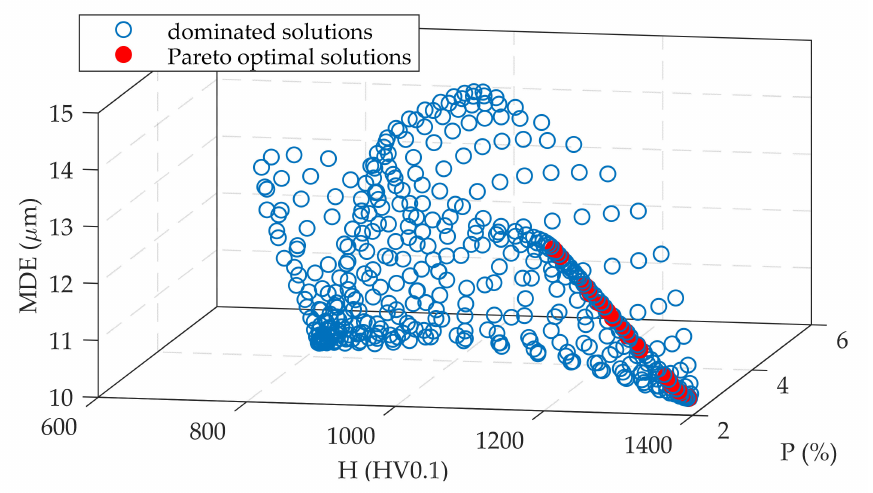
Figure 9. Pareto front in objective